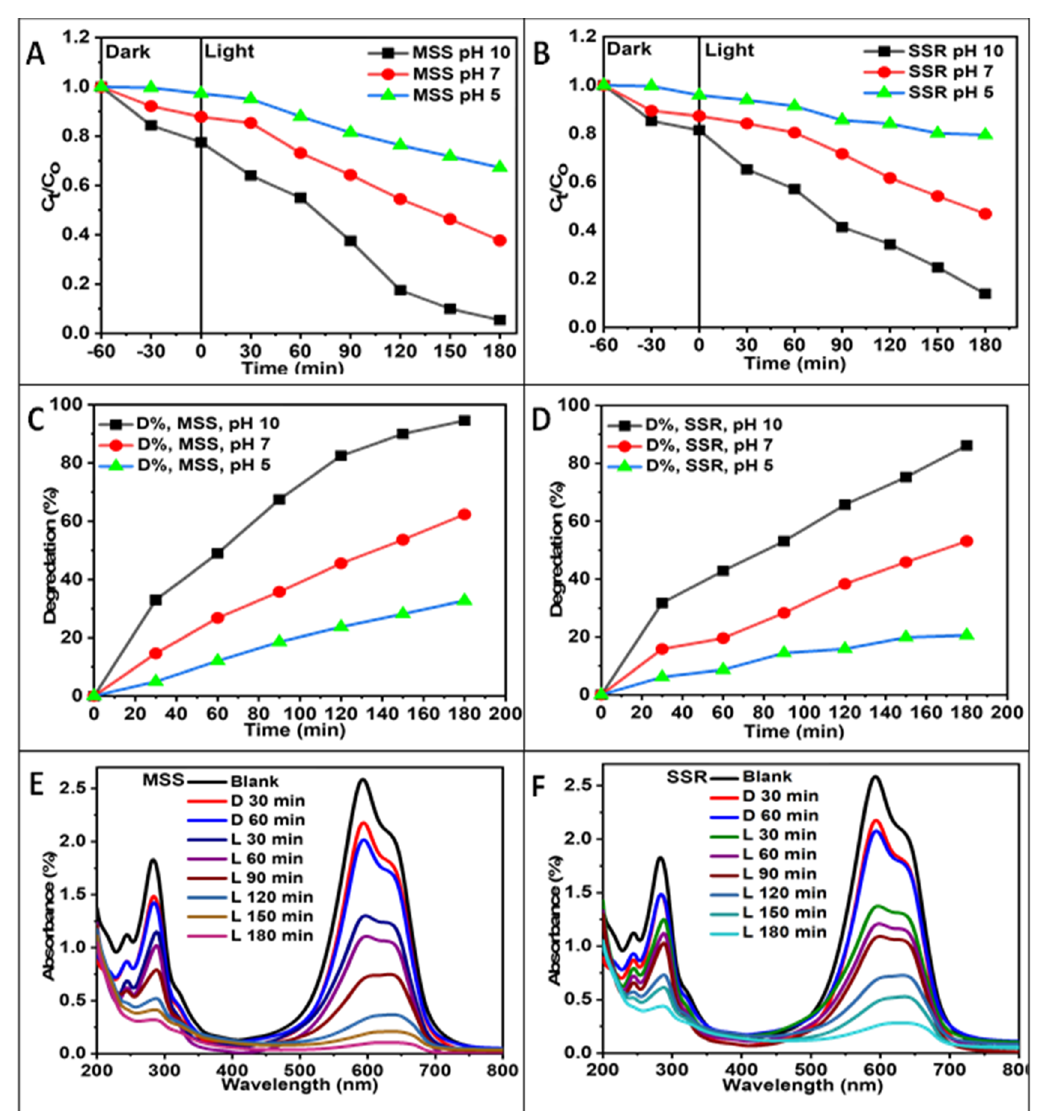
Fig. 9. the effect of pH on the photocatalytic activity of MSS and SSR samples; [A, B]: the change in relative dye concentration with time, [C, D]: degradation percent at different pH values, [E, F]: the absorption peak decay at pH 10,